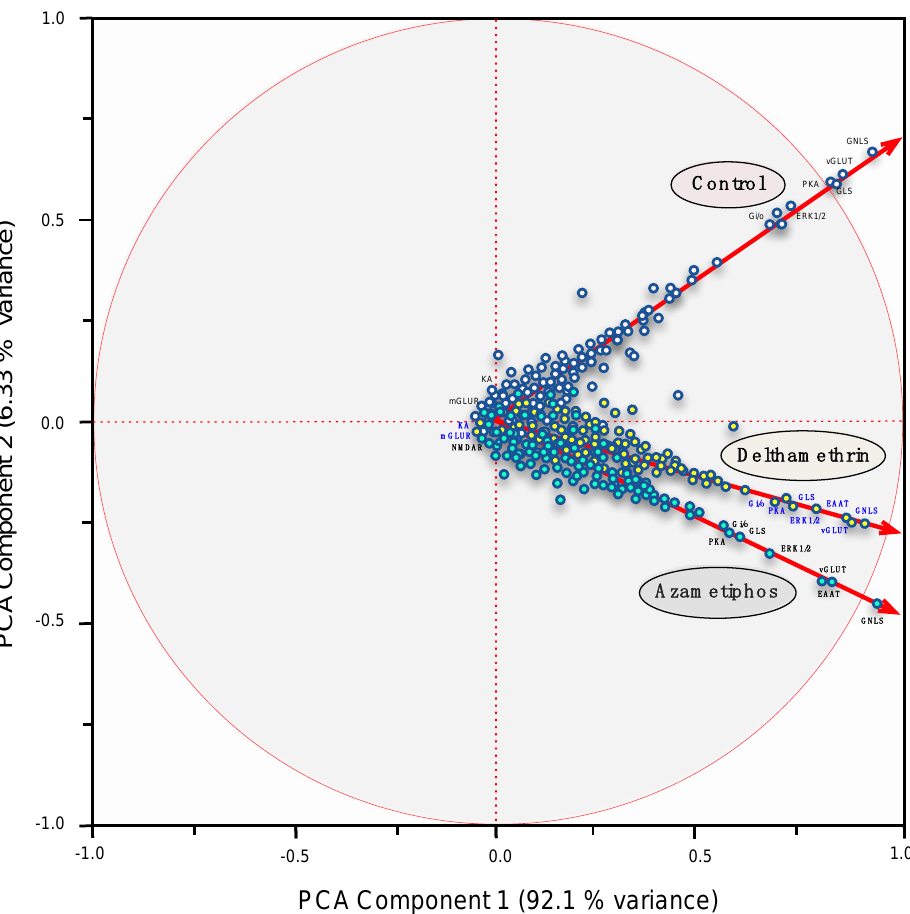
Figure 4. The DeDaL-PCA Cytoscape plugin was used to visualize the network of genetic interactions for downstream components of the glutamatergic pathway affected by delousing drugs. Different node colors indicate distinct mRNA regulation after drug exposures. A principal components analysis (PCA) was applied to the network-smoothed profile. DeDaL used the elastic map (elmap) algorithm for computing non-linear principal manifolds. A factorial map of the PCA was applied to data for components of the glutamatergic pathway, which are represented as colored circles for each treatment condition (white: control; yellow: deltamethrin; and blue: azamethiphos). The portion of the variance explained by the principal component is indicated in parentheses.